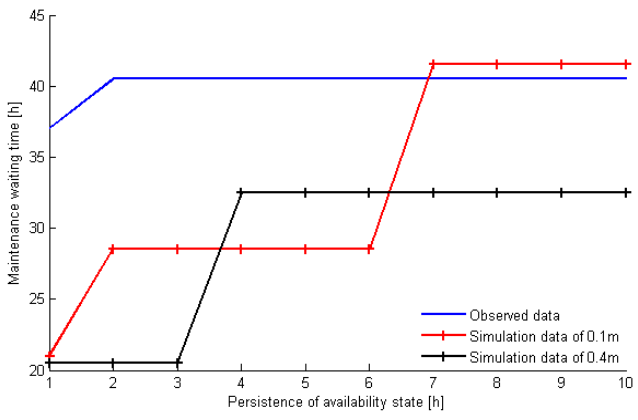
Figure 15. Maintenance waiting time and duration diagram.